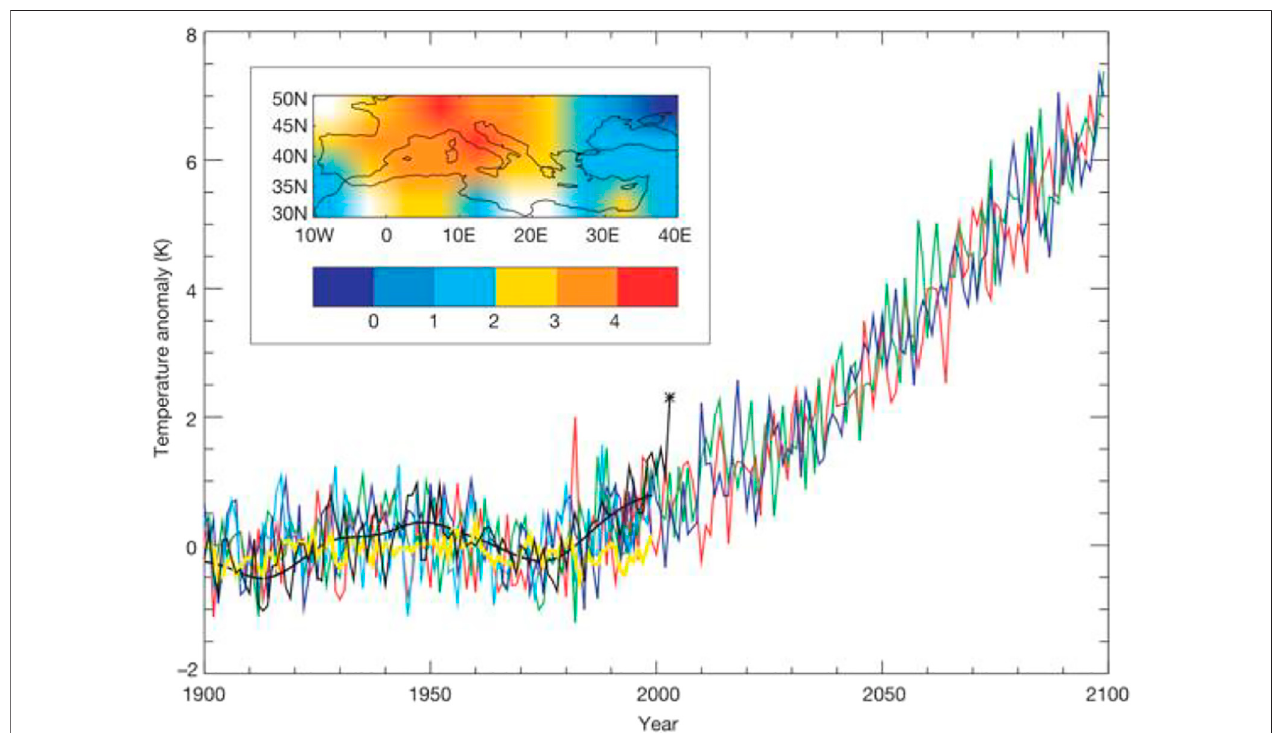
FIGURE 2 | June – August temperature anomalies relative to the 1961 – 1900 mean for Europe (inset). Black line is observed temperatures and heavy black line is a lowpass fi lteredtemperature.Colorsarefuturemodeledtemperatures;heavyyellowlineisnaturalforcing.Observedtemperature for2003isshownasastar(fromStott et al., 2004. Reprinted by